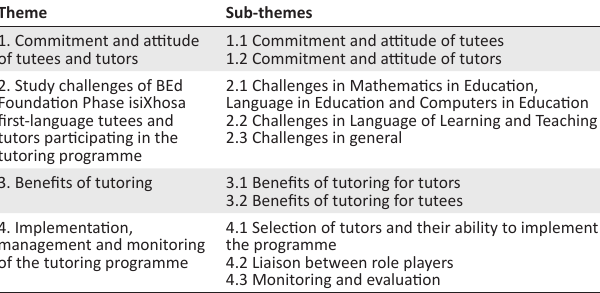
TABLE 1: Key themes and